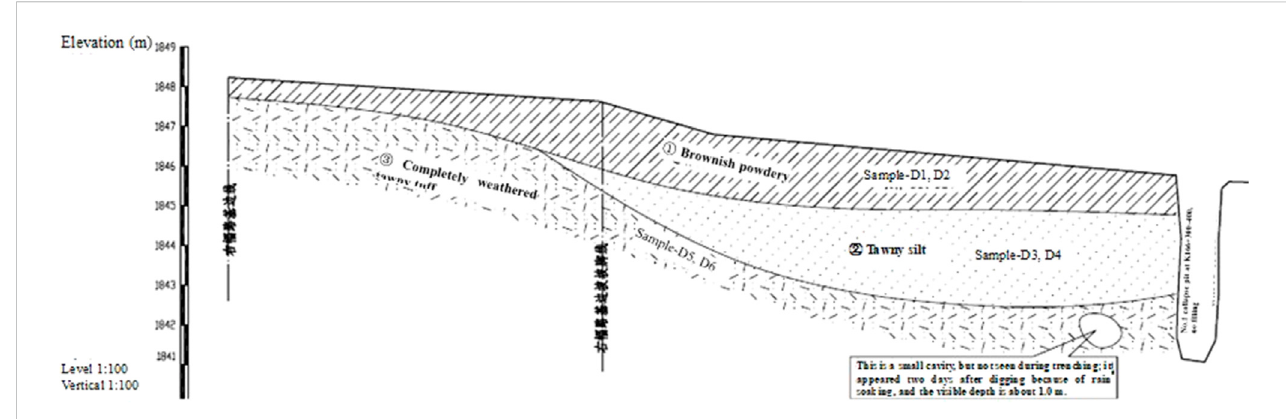
FIGURE 14 Engineering geological pro fi le of the TC4 trench.